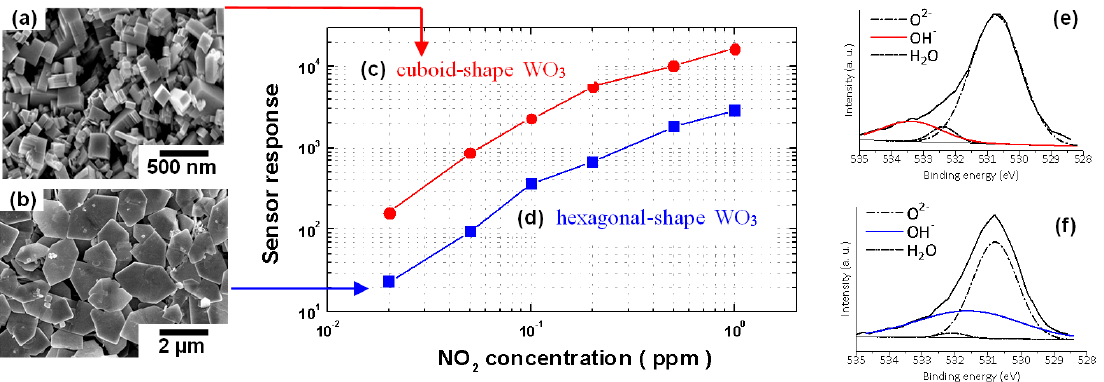
Figure 1. FE-SEM images of ( a ) cuboid-shape monoclinic WO 3 nanocrystal and ( b ) hexagonal-shape hexagonal WO 3 nanocrystal. Sensor response as a function of NO 2 concentration for ( c ) cuboid-shape WO 3 and ( d ) hexagonal-shape WO 3 . XPS spectra of O 1s on the surface of ( e ) as-prepared cuboid-shape WO 3 and ( f ) hexagonal-shape WO 3